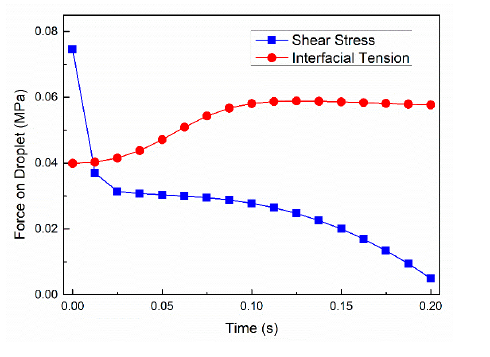
Figure 13. Shear stress and interfacial tension during mold filling.